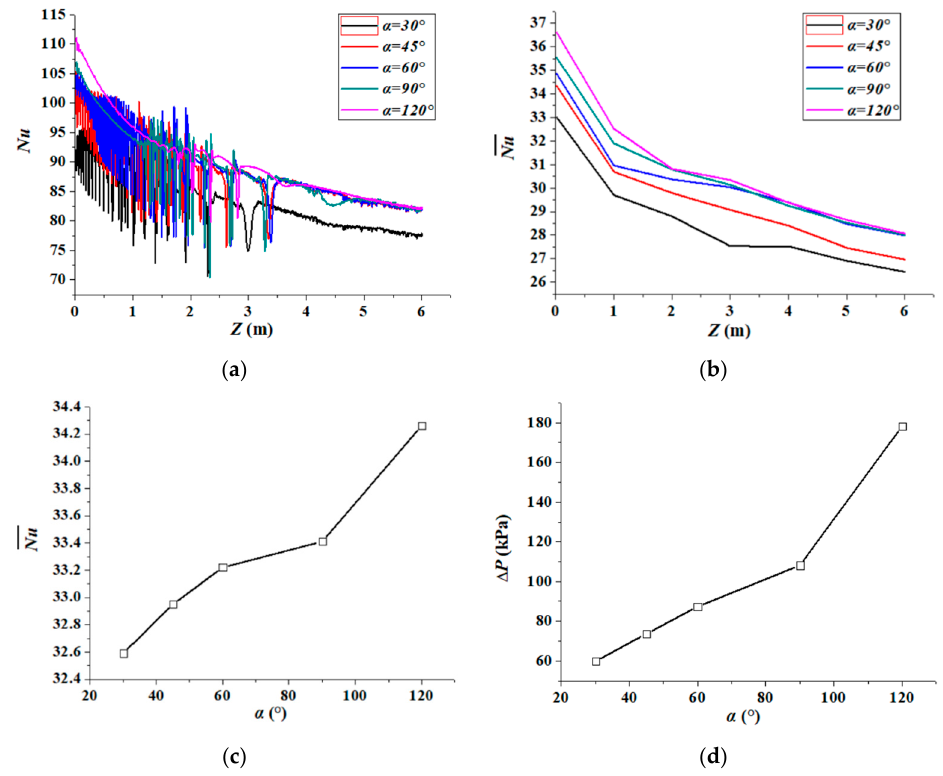
Figure 16. Nu and Δ p for different α values: ( a ) Nu on Line 2; ( b ) average Nu along the tube; ( c ) average Nu of whole tube; ( d ) pressure loss.